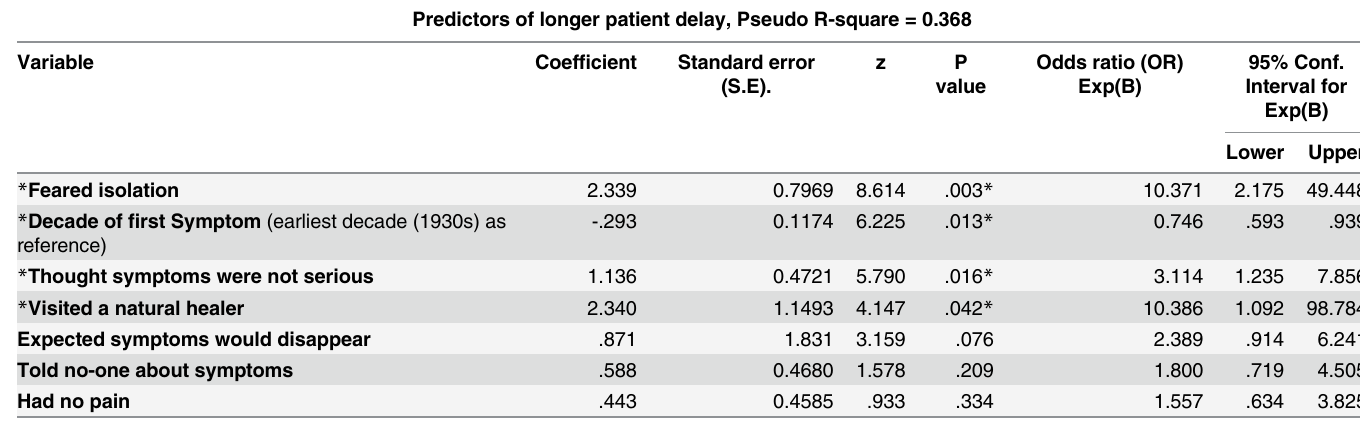
Table 4. Ordinal and logistic regression models for predictors of longer presentation time and delayed presentation respectively. Predictors of longer patient delay, Pseudo R-square =